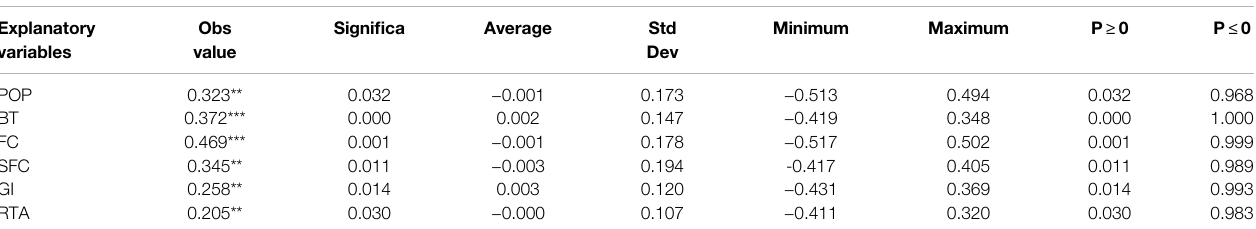
TABLE 5 | Results of QAP correlation analysis in 2014. Explanatory